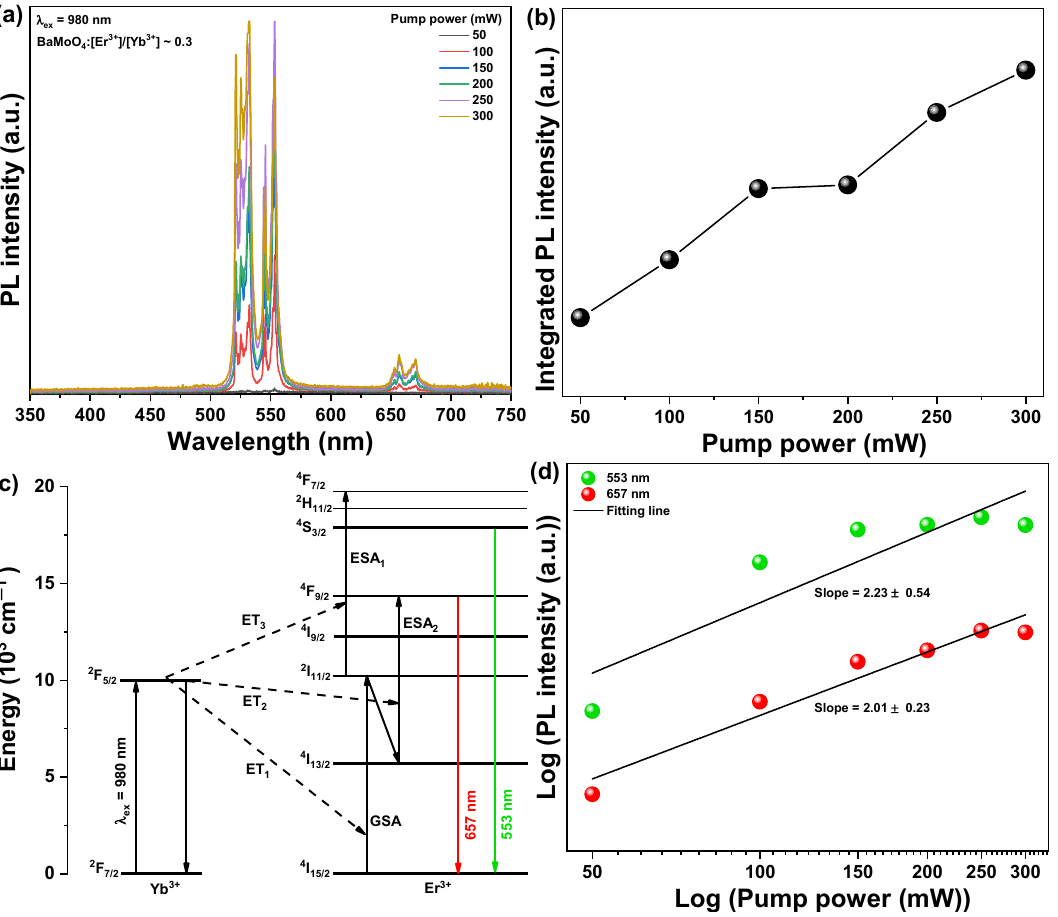
Figure 5. ( a ) PL spectra; ( b ) Change in integrated PL intensity; ( c ) Schematic energy transfer process; and ( d ) Linear fitting at 553 and 657 nm intensity according to pump power under 980 nm of BaMoO 4 :[Er 3+ ]/[Yb 3+ ] ~0.3 up-conversion phosphors.